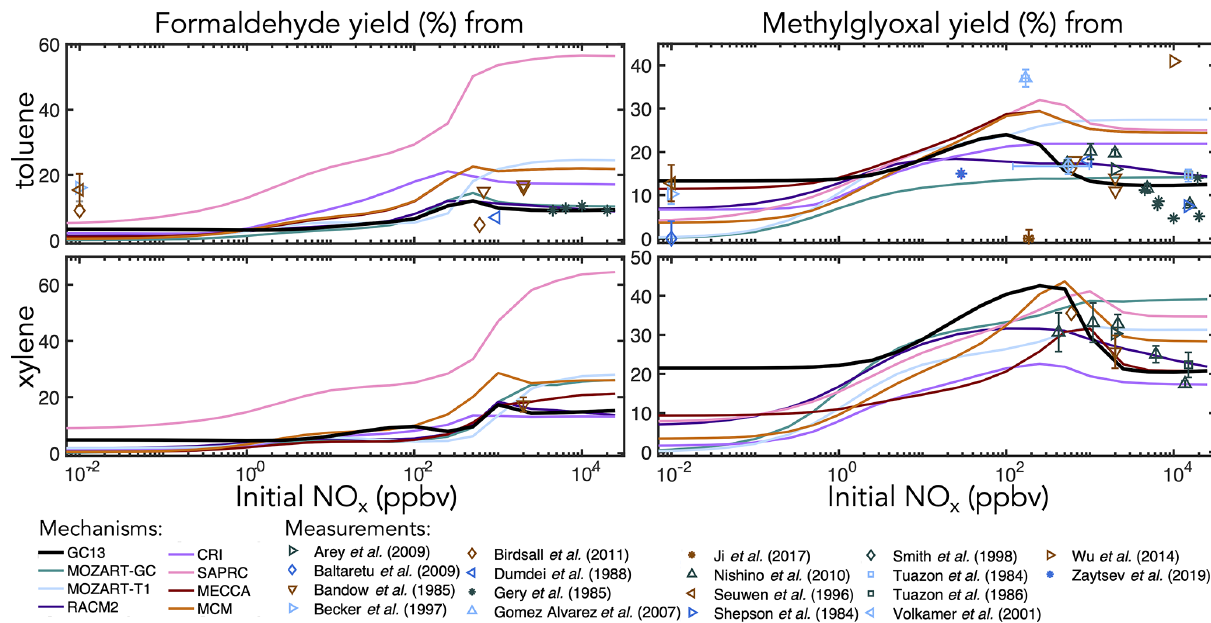
Figure 6. Experimental (points) and simulated (lines) prompt molar yields of methylglyoxal and formaldehyde from toluene and xylene oxidation in environmental chambers as a function of initial NO x mixing